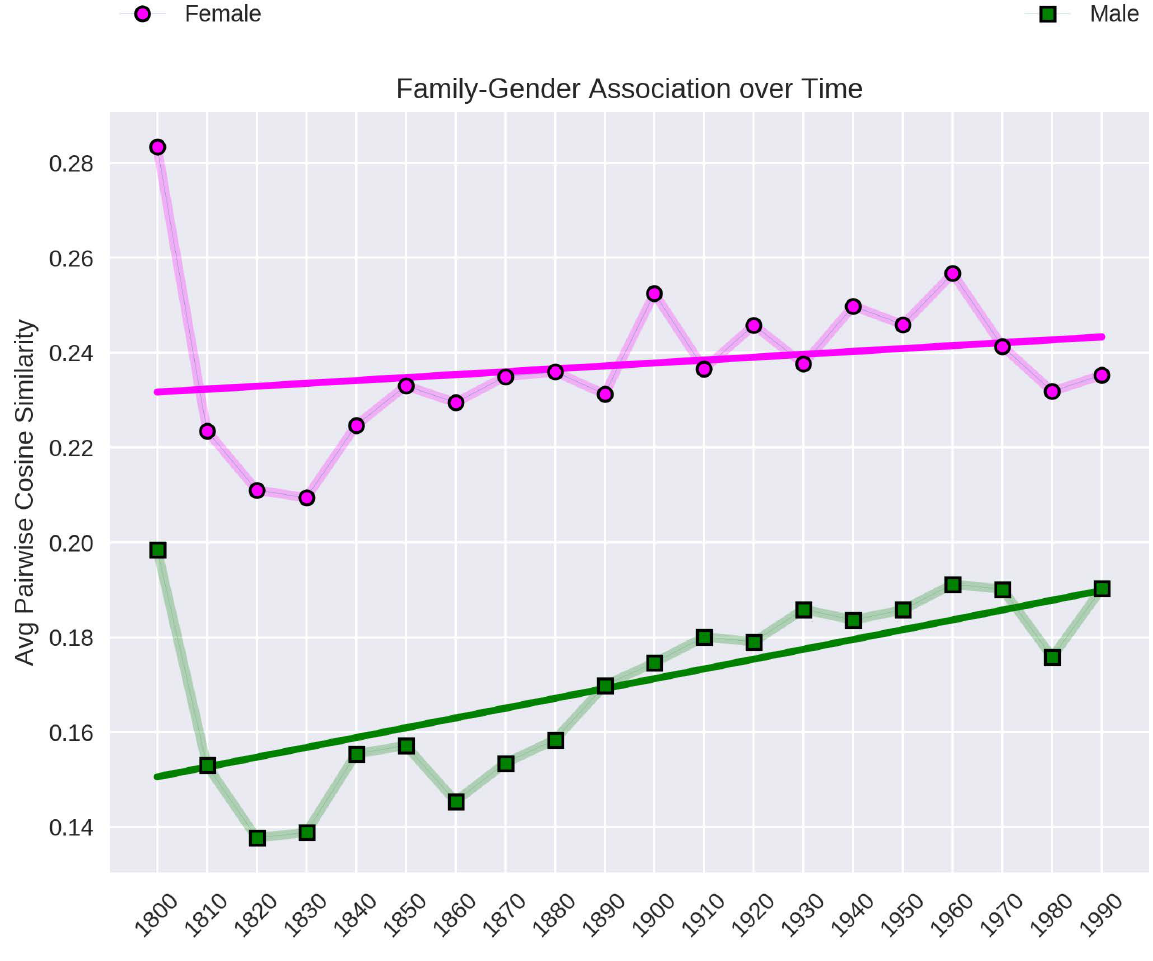
Figure 3: Female association and male association with the Family domain measured by decade. The x axis is labeled with the first year of each decade (e.g., the label “1910” is used to mark the measurement based on the word embedding trained on text from 1910 up to but not including 1920). Avg,